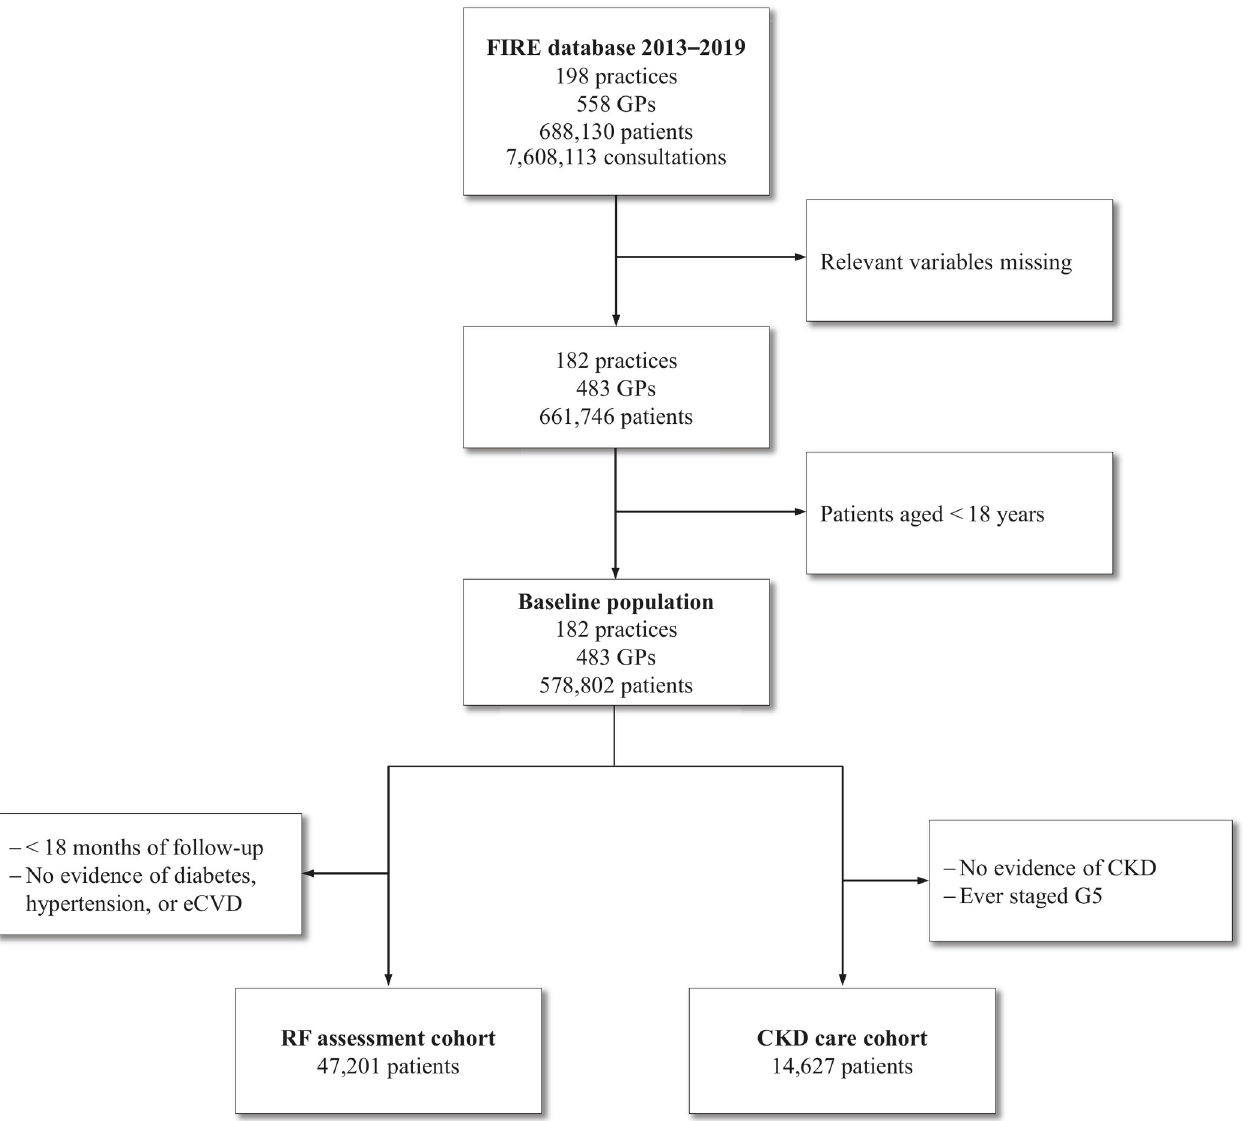
Fig 1. Study flowchart. Selection of the renal function (RF) assessment cohort and the chronic kidney disease (CKD) care cohort. Abbreviations: eCVD, established cardiovascular disease; GP, general practitioner.